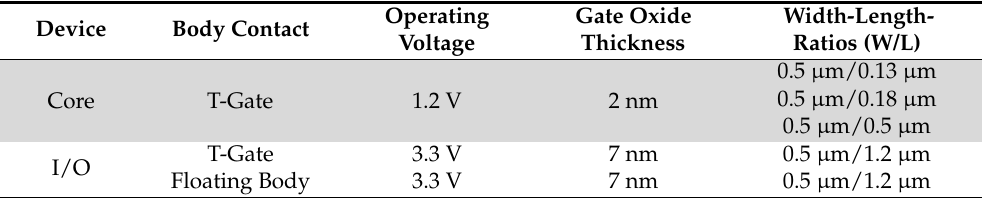
Table 1. The two kinds of devices in the 130 nm PDSOI technology.